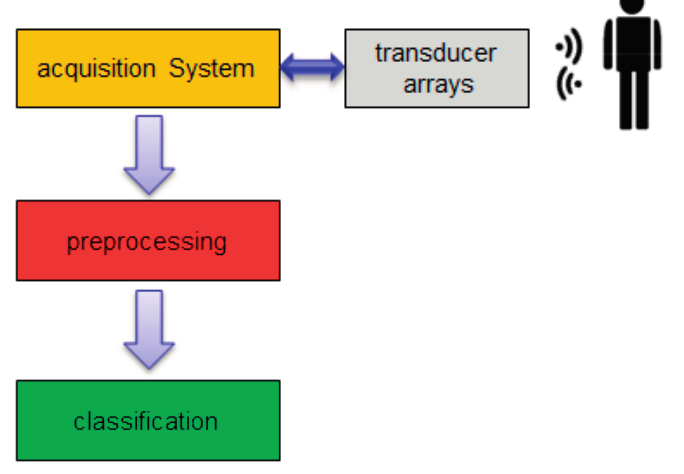
Figure 4. Functional description block diagram.